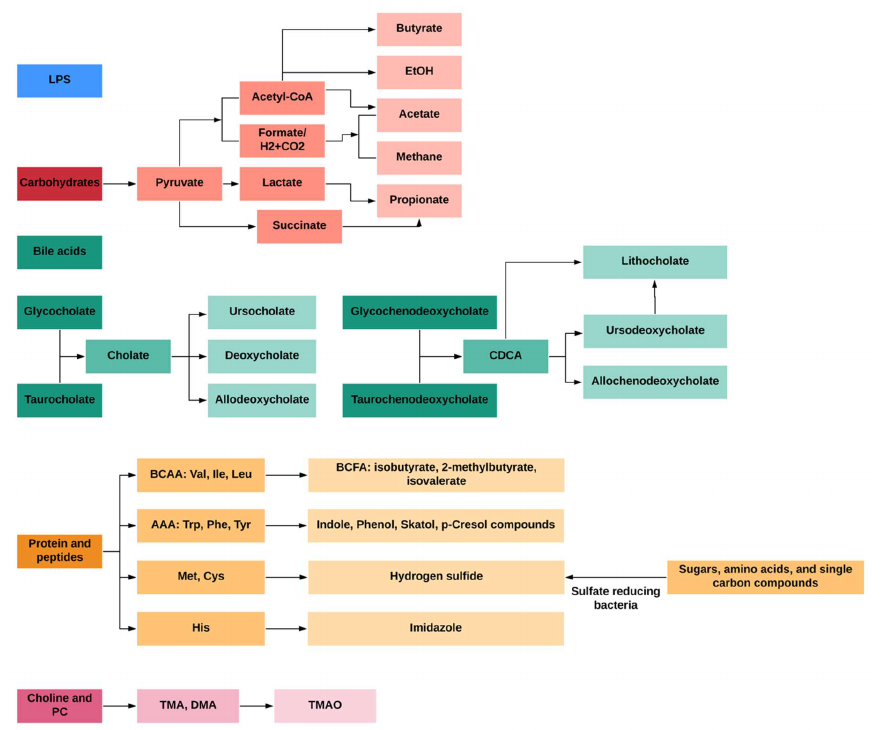
Figure 1. General profiles of gut-microbial metabolites from different dietary and endogenous components in humans. Table 1. Concentrations of gut microbial metabolites in human healthy host.